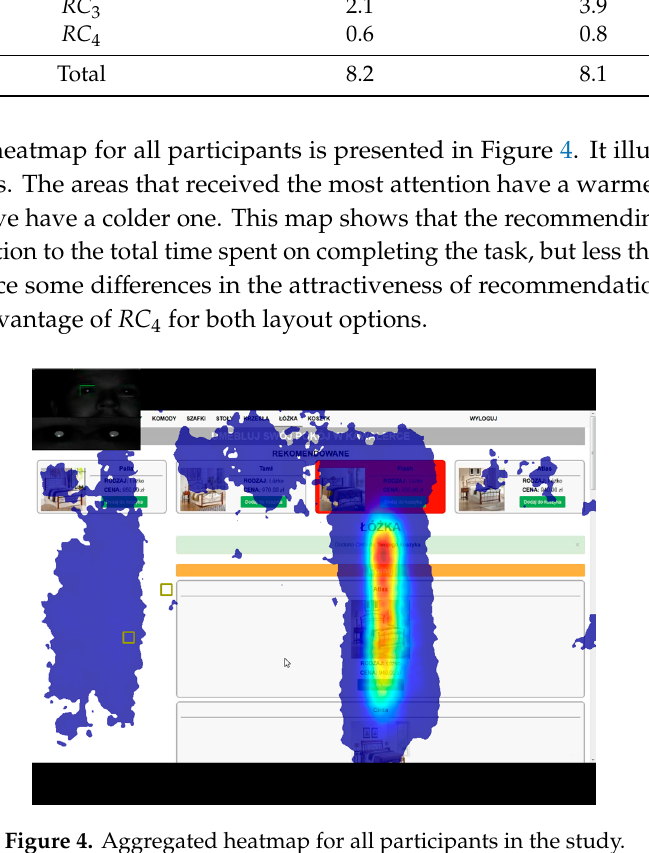
Figure 4. Aggregated heatmap for all participants in the study.